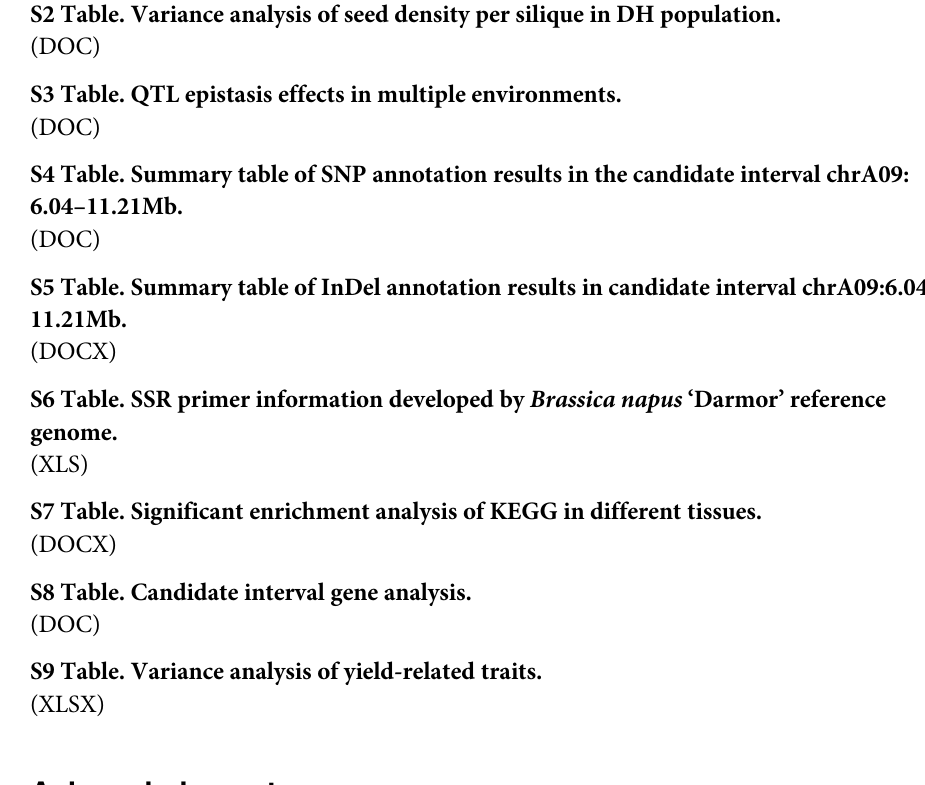
S1 Table. Genetic linkage map information. S2 Table. Variance analysis of seed density per silique in DH population. S3 Table. QTL epistasis effects in multiple environments. S4 Table. Summary table of SNP annotation results in the candidate interval chrA09: